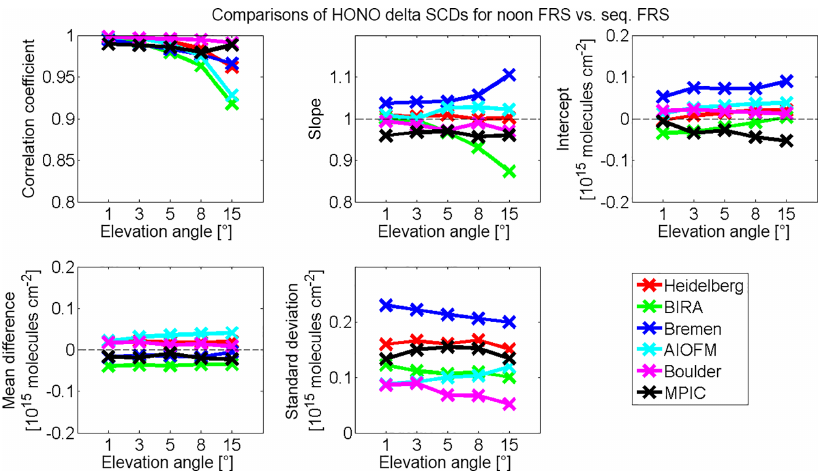
Figure 6. Correlation coefficients, slopes and intercepts of linear regressions as well as mean differences and standard deviations derived from the comparisons of the HONO delta SCDs retrieved by fits between with a daily noon FRS and a sequential FRS as function of the elevation angle for individual instruments. The colour curves indicate different instruments.